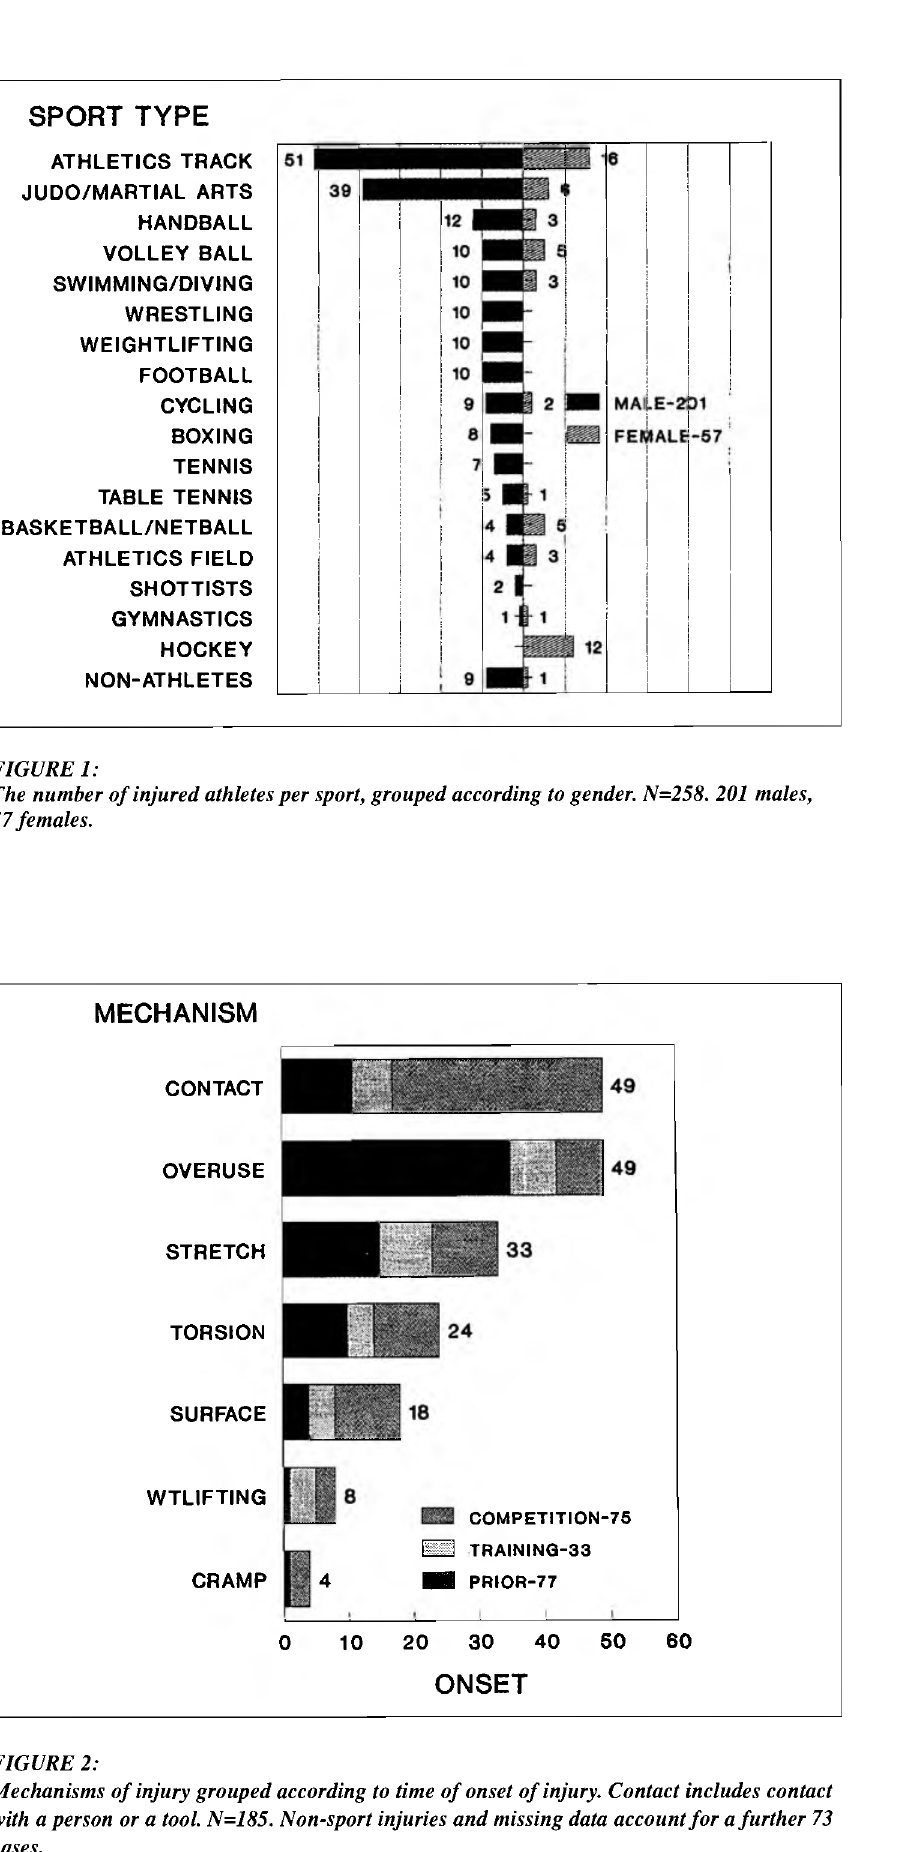
Mechanisms of injury grouped according to time of onset of injury. Contact includes contact with a person or a tool. N=185. Non-sport injuries and missing data account for a further 73